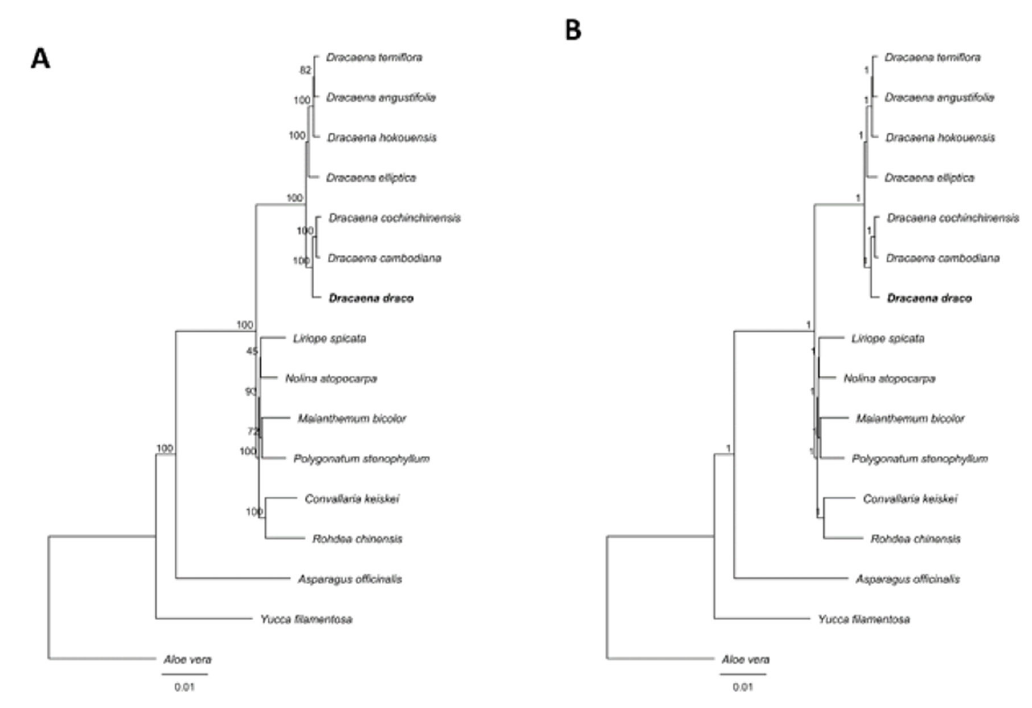
Figure 4. Phylogenetic relationships among the 16 Asparagales species based on complete chloroplast genomes inferred from: Maximum Likelihood ( A ) and Bayesian inference ( B ). The numbers near each node are bootstrap support values obtained by ML ( A ) or show the posterior probabilities according to BI ( B